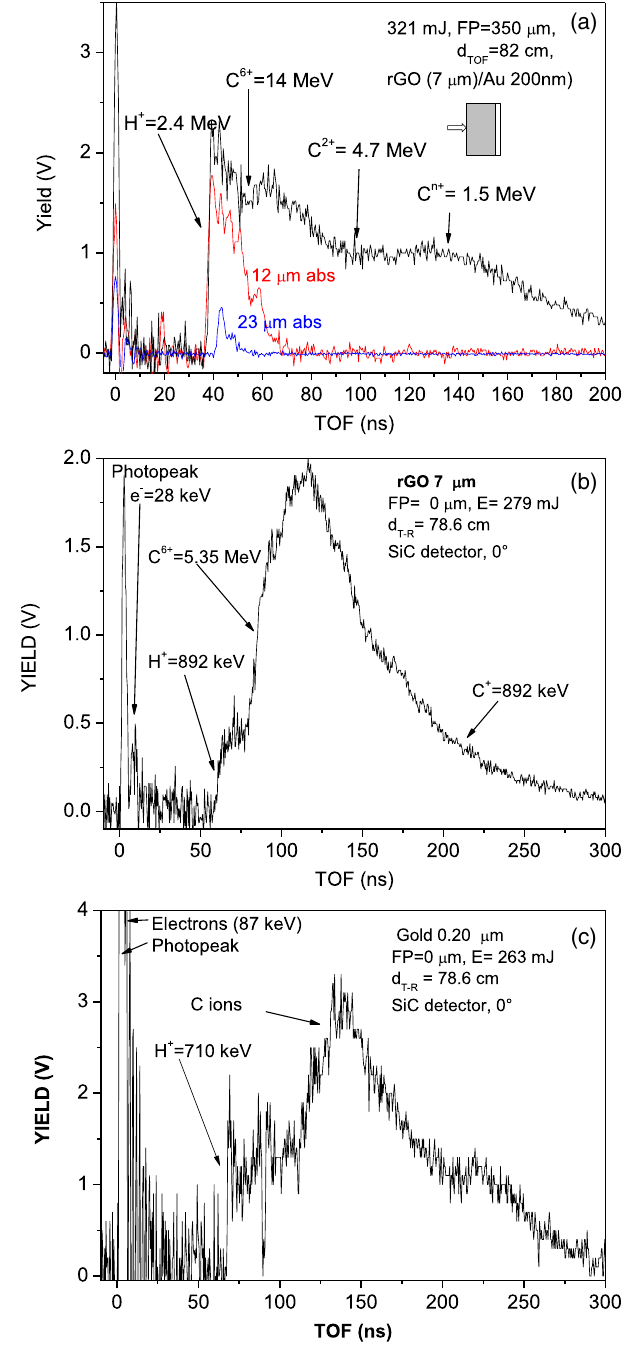
FIG. 5. SiC spectra obtained irradiating the sample from the GO side (a), irradiating the only GO foil without Au film (b) and irradiating the only 200 nm Au film without GO